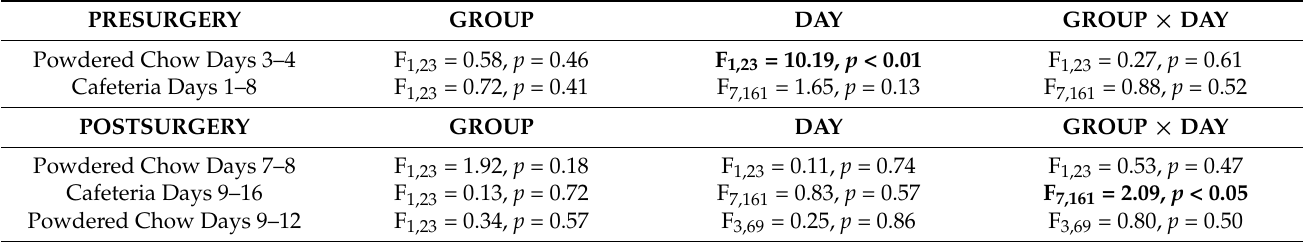
Table 12. Two-way ANOVAs Comparing 22-H Intermeal Interval between Groups for Each Diet Condition. Table 13. Paired t -tests Comparing 22-H Intermeal Interval within Groups across Diets.